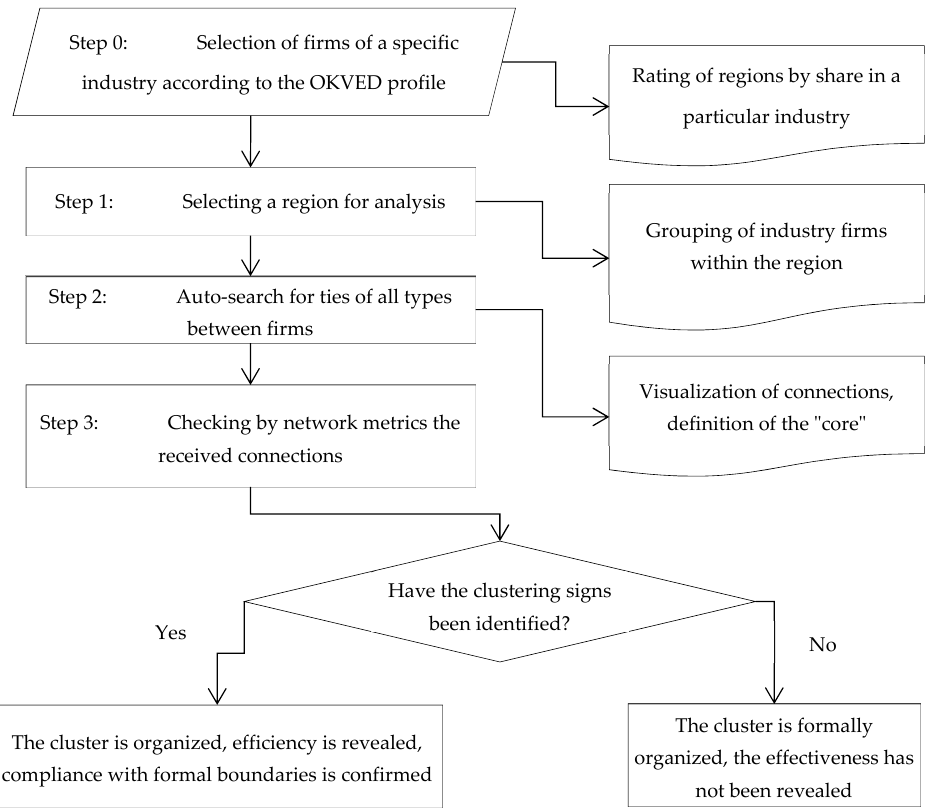
Figure 1. The approach to identifying clusters based on representing them as a network of interact- ing firms.